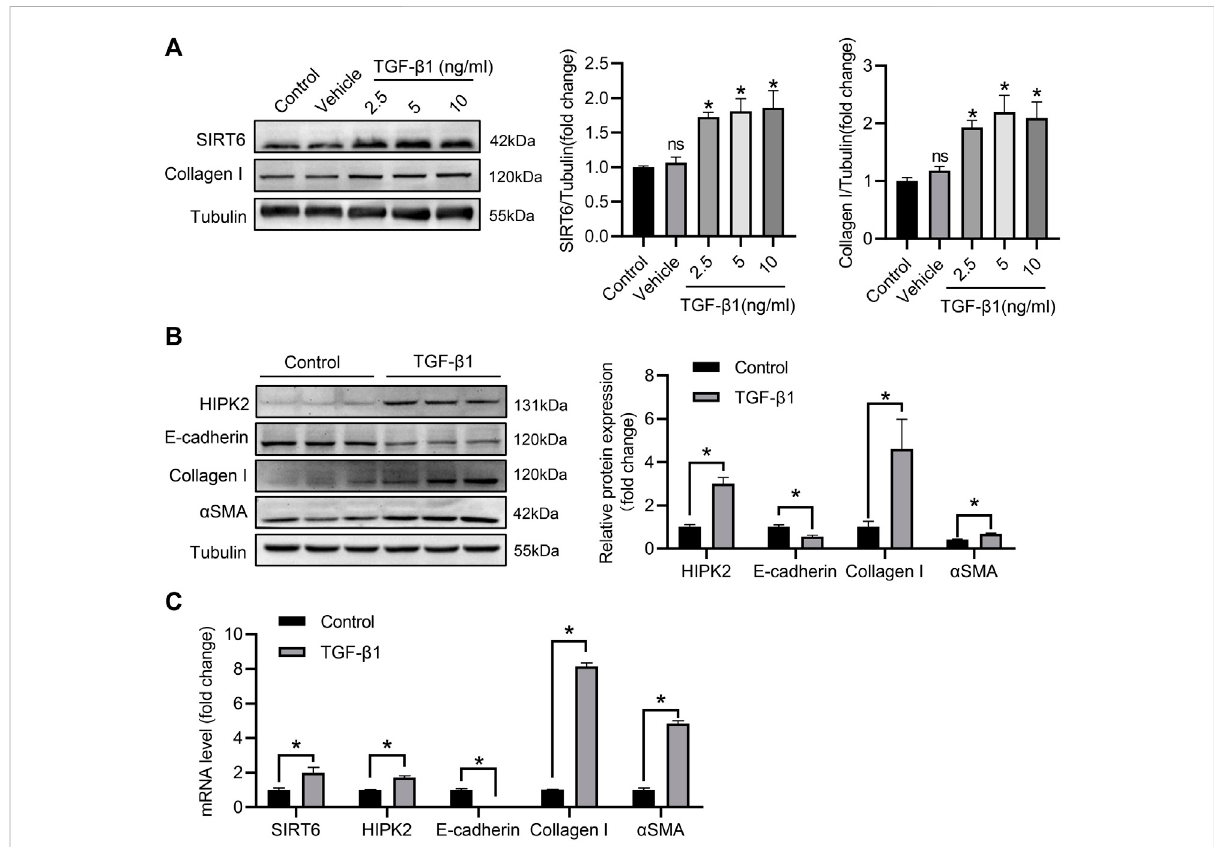
FIGURE 3 SIRT6andHIPK2areinducedbyTGF- β 1inHK2cells. (A) WesternblotanalysisofSIRT6andcollagenIexpressioninHK2cellsexposedtoTGF- β 1 for 48 h with indicated dose. n = 3. (B) Western blot analysis of HIPK2 expression in HK2 cells exposed to 2.5 ng/ml TGF- β 1 for 48 h n = 3. (C) Quantitative real-time PCR analysis of genes expression in HK2 cells treated with TGF- β 1. n = 3. All values are presented as mean ± SEM. * p <